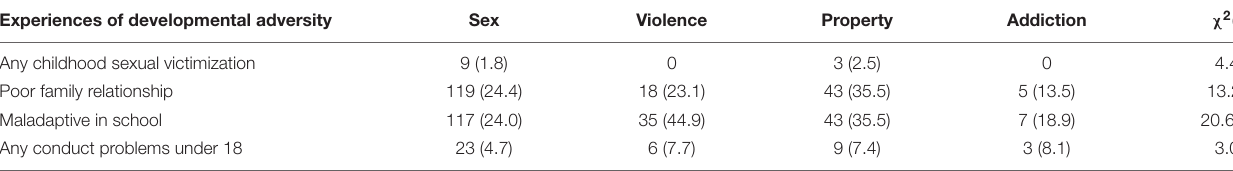
TABLE 5 | Onset-group comparison with experiences of developmental